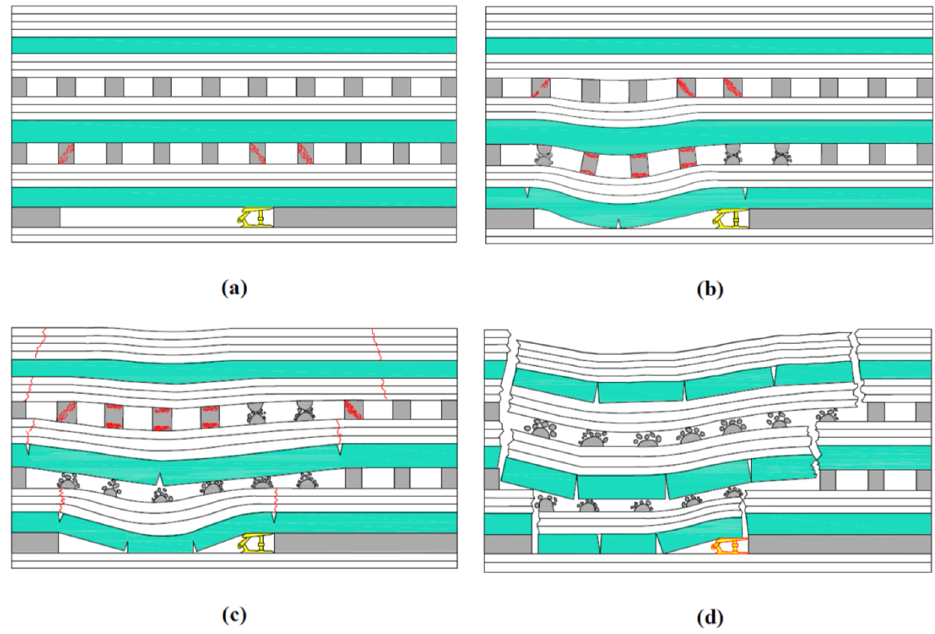
Figure 10. Diagram of disaster mechanism caused by dynamic collapse of coal pillars. ( a ) Diagonal failure of pillars of the No.4 coal seam first occurs; ( b ) Continuous shear failure of adjacent coal pillars; ( c ) Local overall failure of pillars of No.3 coal seam; ( d ) Whole-rock strata cut to strong ground.